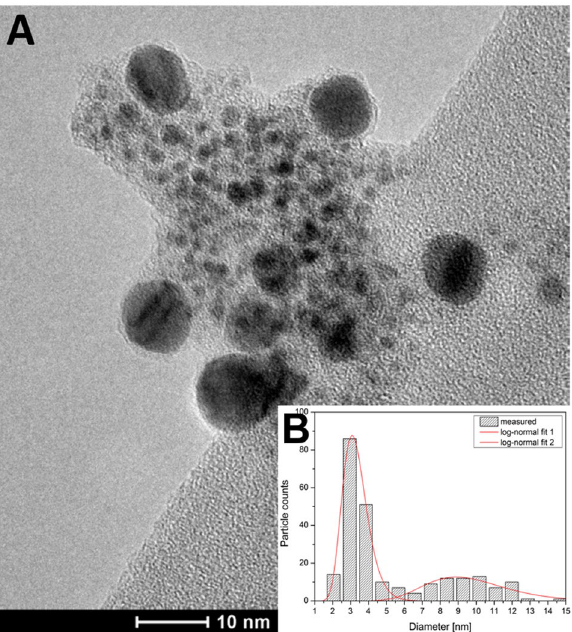
Figure 7. TEM micrograph of Au/Co BNPs generated at 5.4 Ω circuit resistance without heat-treatment ( A ), and the size distribution of 237 particles ( B ).